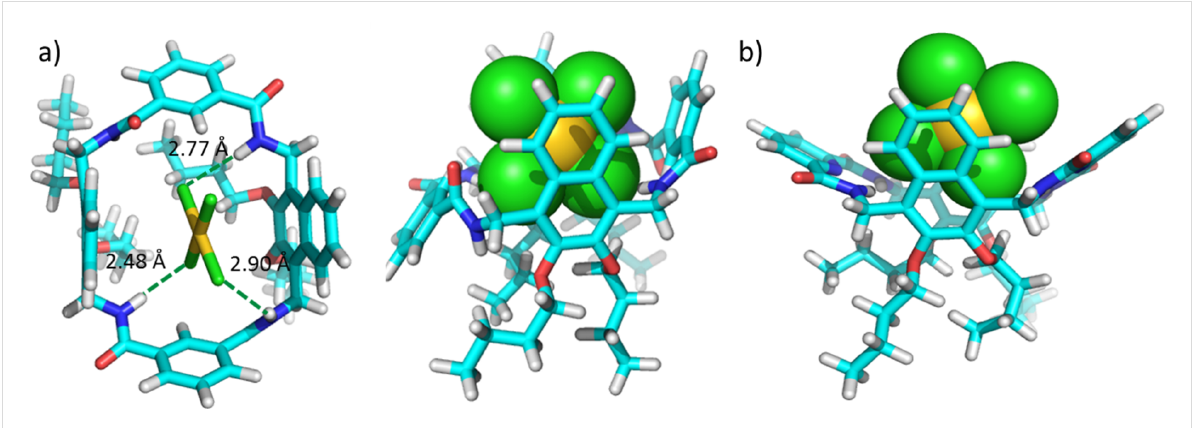
Figure 5: Energy-minimized structure of a) AuCl 4 − @ 1 and b) AuCl 4 − @ 2 at the level of theory of PM3 by using Spartan ’14 (Wavefunction, Inc.).